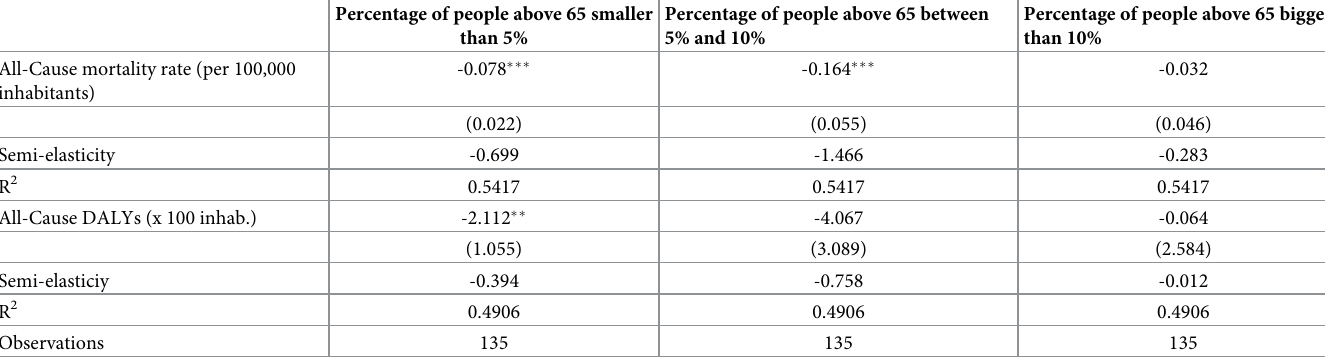
Table A4. The effect of mortality/DALYs on GDPpc growth. Long-Run Growth Regression. Effects by Percentage of people over 65. OLS.